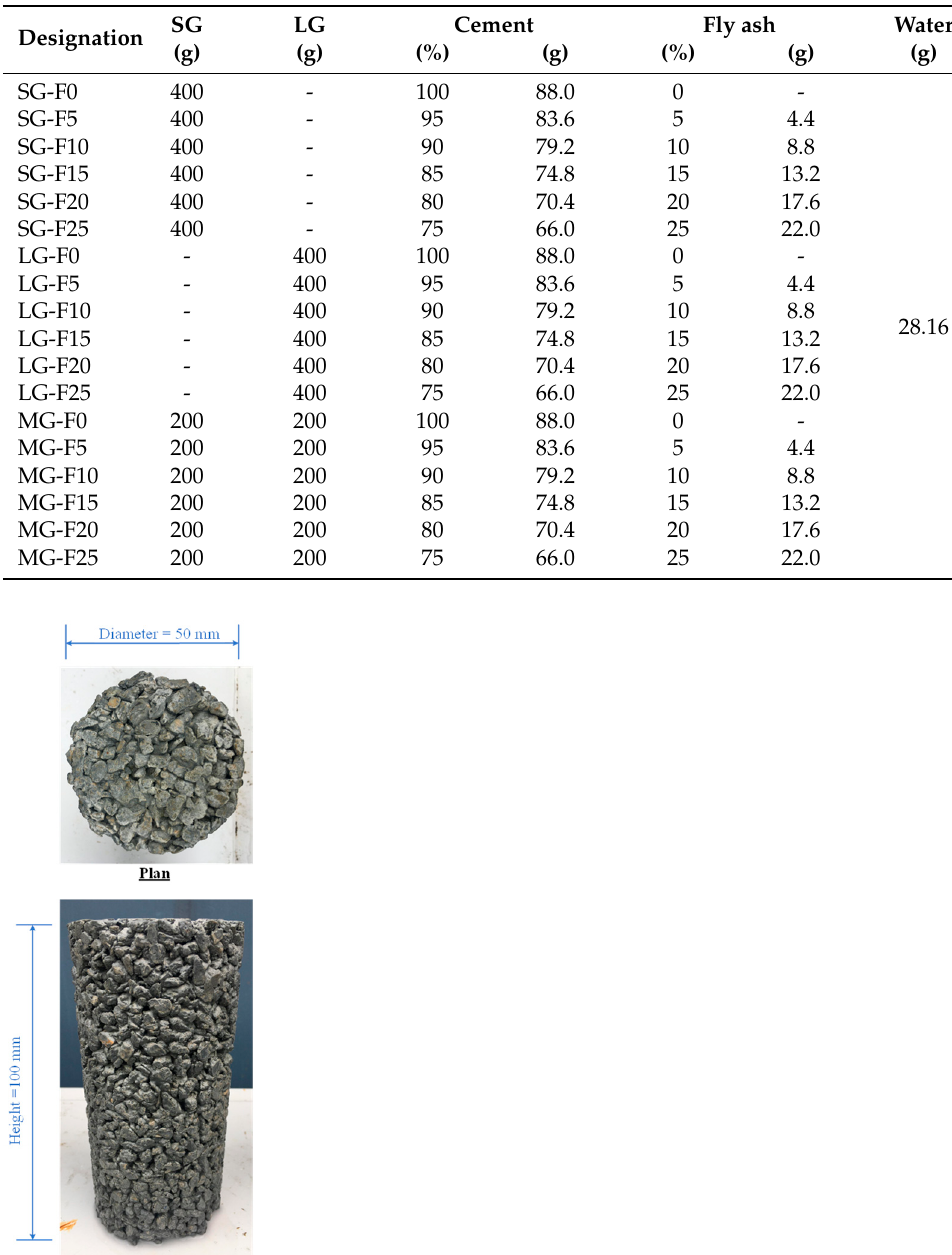
Table 3. Mixture proportions for one cylinder of the CFG column.